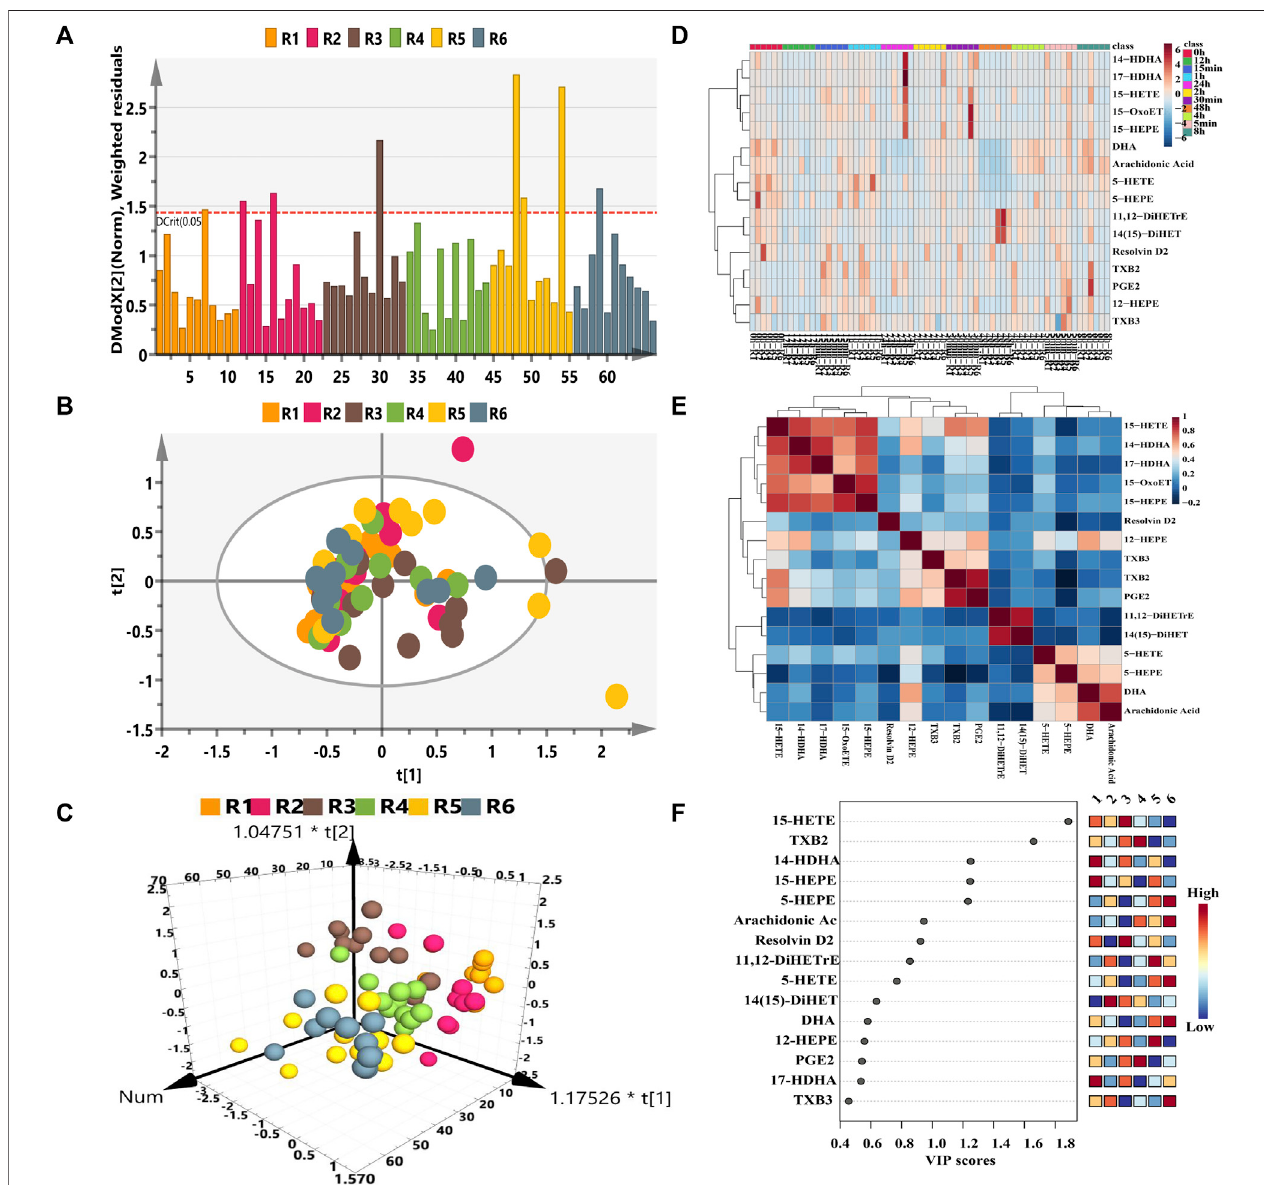
FIGURE 2 | Longitudinal eicosanoid metabonomic fi ngerprints of remdesivir. (A) DModX analysis for data quality. (B) PCA score plots from six rats. (C) OPLS-DA scoreplotsfromsixrats. (D) Hierarchicalclusterheatmapofallmetabolitesatdifferenttimepoints.Thecolorscalesmarkrelativeintensityafternormalizationandscaling. (E) Differential metabolite correlation heatmaps for plasma samples. The color scale (right) indicates the degree of correlation of metabolites (red-positive correlation, blue-negative correlation). (F) Metabolites of VIP values > 1.